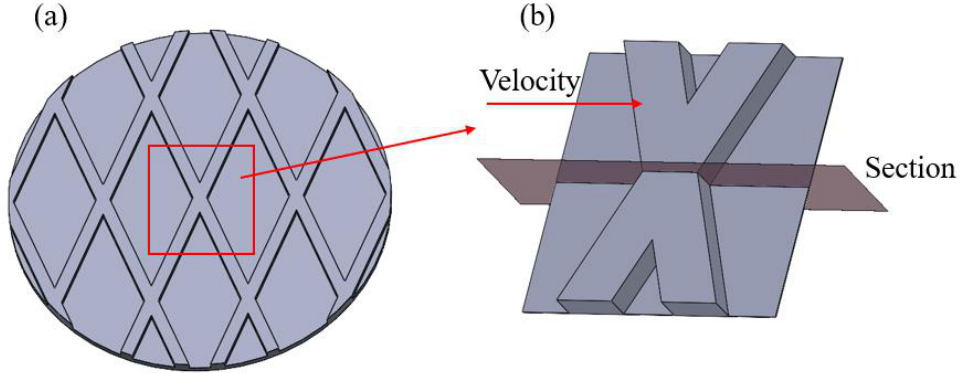
Figure 5. Three-dimensional model. ( a ) Complete textured fluid; ( b ) part of the textured fluid. Figures 6 and 7 show the static pressure distribution and velocity contour distribution on different reticular-textured surfaces. Along the velocity direction, the negative pressure appeared first and then the pressure peak appeared, because the existence of the reticular texture caused convergence and divergence zones to develop. When the fluid flowed to the texture along the velocity direction, a divergent zone formed negative pressure. When the fluid flowed out of the texture, a convergence gap formed, and a pressure peak appeared [1,5]. Figure 6 shows that the pressure tended to increase with the increase in the groove width, and the distribution range of the positive pressure also continuously in-